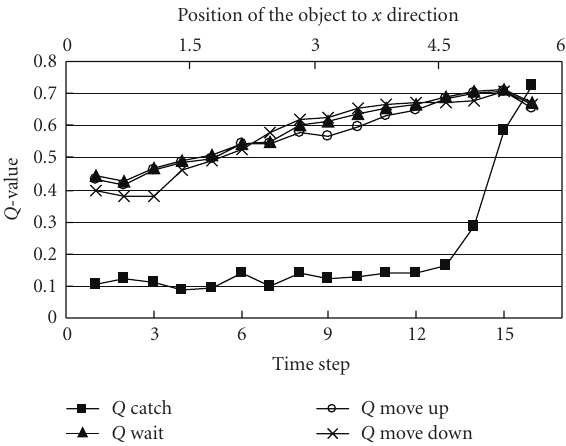
Figure 5: Change in Q -values in an episode. Four lines show the change in Q -values for the actions, “catch”, “wait”, “move up”, and “move down”. If the action is selected greedily, the action with the maximum Q -value is chosen.